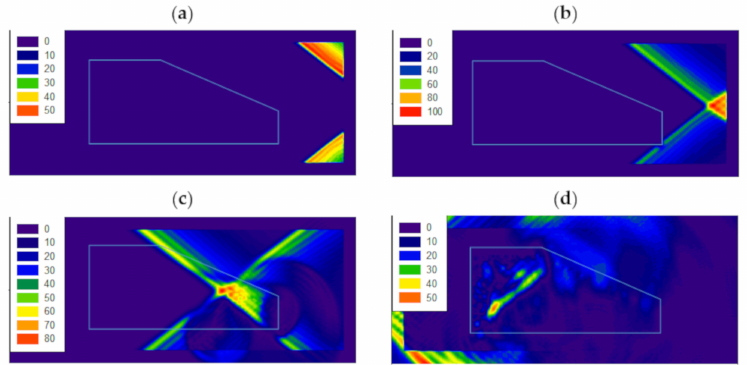
Figure 6. Distribution pattern of the electric field in the yoz plane at different time steps. ( a ) Time step = 50; ( b ) time step = 100; ( c ) time step = 200; ( d ) time step = 300.